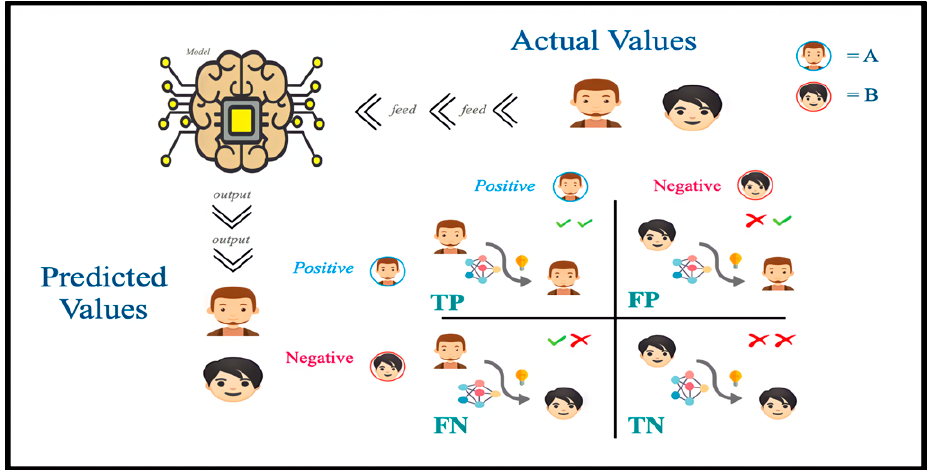
Figure 9. The Confusion Matrix for face recognition.